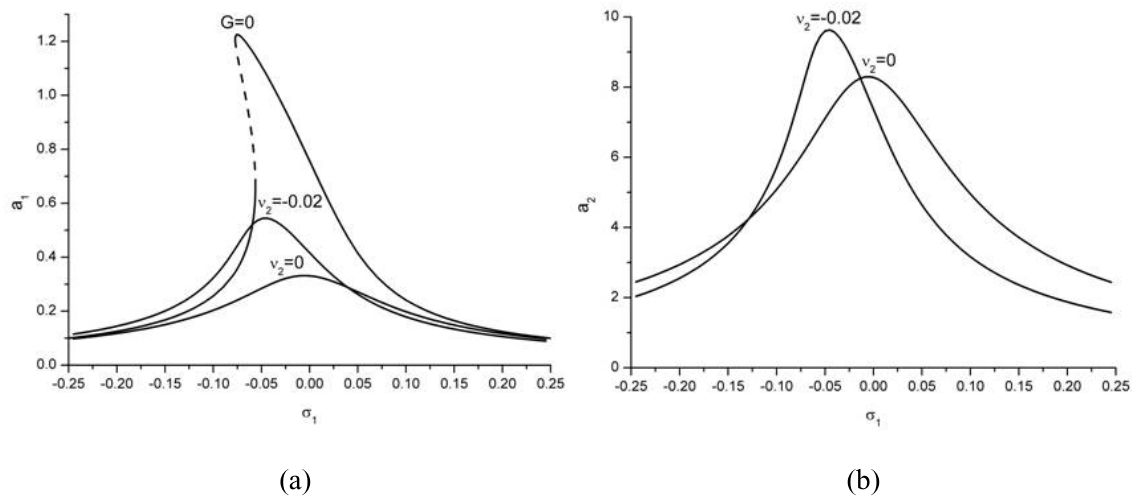
Fig. 6. Effect of detuning the absorber’s frequency on the frequency-response curves of (a) the plant and (b) the absorber when f = 0 . 025 , G = 0 . 005 and ζ = 0 . 02 .